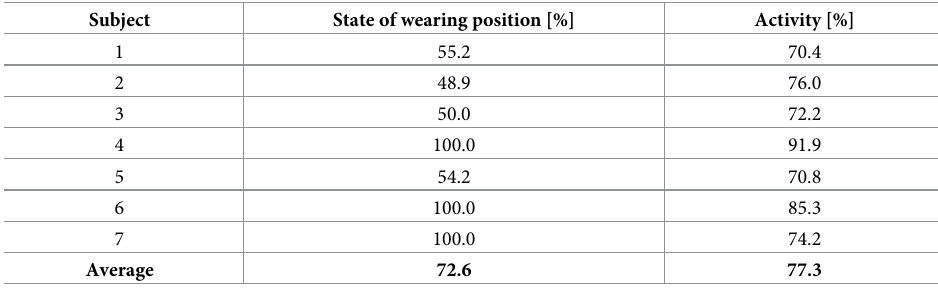
Table 1. Averaged results of the proof of concept study with healthy